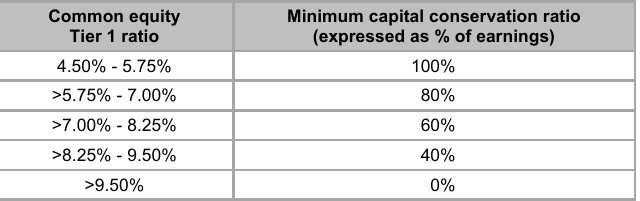
Individual bank minimum capital conservation standards, when a bank is subject to a 2.5%x RWA countercyclical